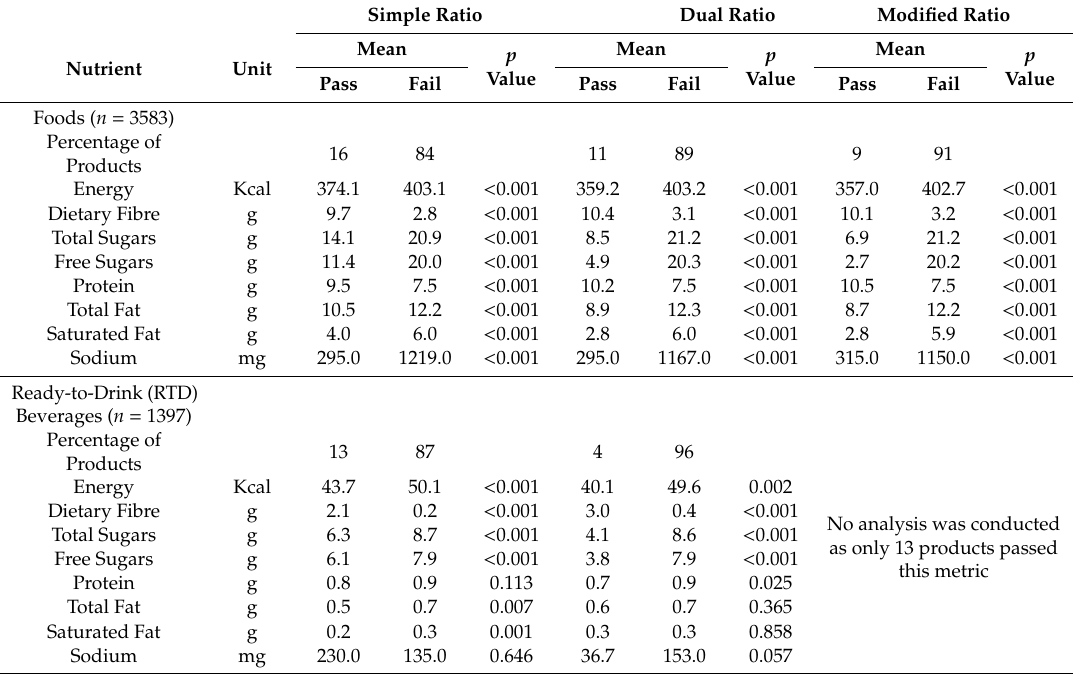
Table 4. Comparison of mean nutrient composition of carbohydrate-based packaged food and beverage products from Mintel Asia that passed or failed the three carbohydrate